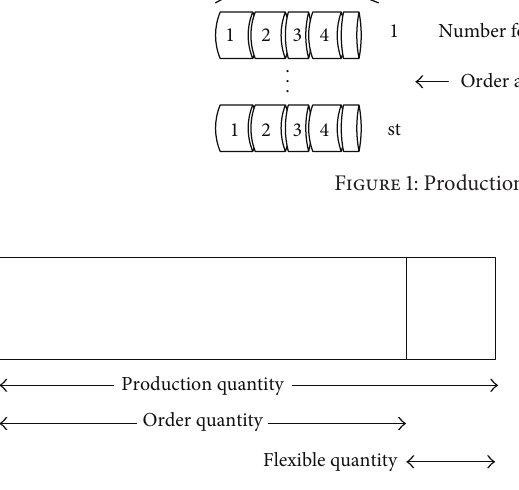
Figure 2: Information of order and